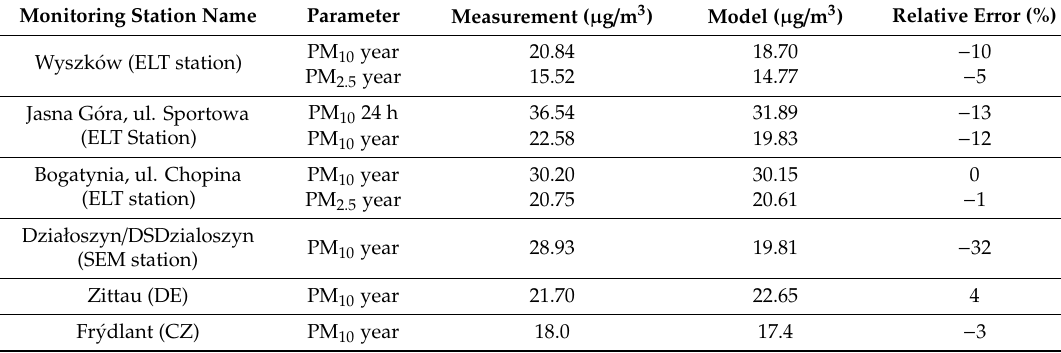
Table 4. Annual mean concentrations of PM 10 and PM 2.5 modeling results and